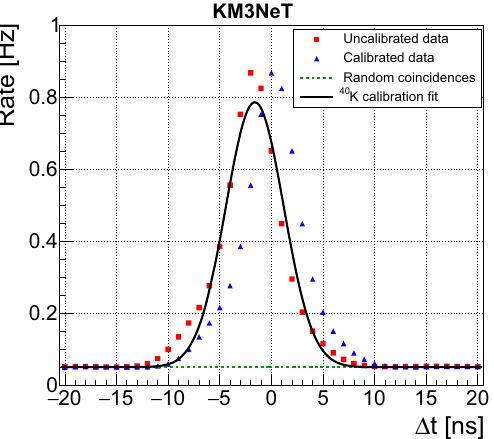
Fig. 3 Distribution of time differences between hits in coincidence for one typical pair of adjacent PMTs, before (red) and after (blue) calibration. In these, only statistical errors are shown, which are smaller than the symbols. A peak due to genuine 40 K coincidences is observed above a flat background (green). The black line is a Gaussian fit of the calibration model (see text) to the uncalibrated data of all PMT